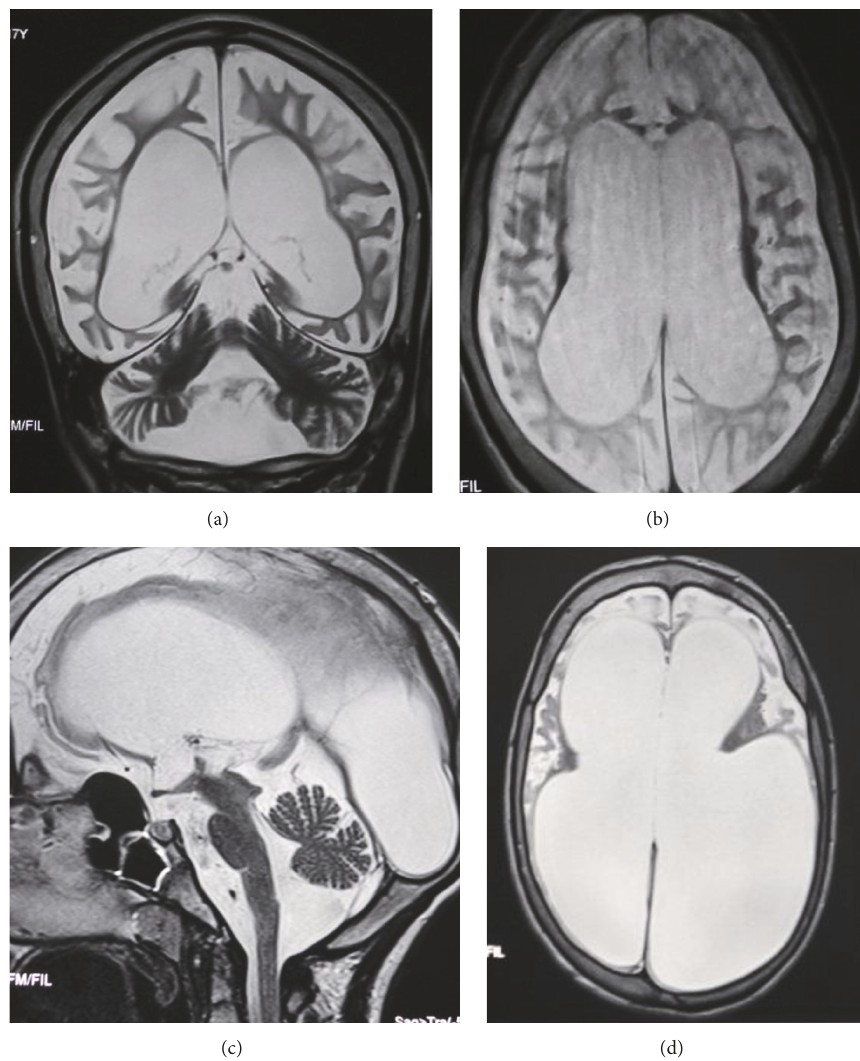
Figure 2: Brain MRI of the patients V.1 ((a) and (b)) and V.2 ((c) and (d)). (a) Coronal T2 weighted image showing enlargement of the cortical furrows and the ventricular cavities related to a diffuse cortical and subcortical atrophy. (b) Axial T2 weighted sequence showing the huge cortical and subcortical atrophy. (c) T2 weighted sequence shows dilatation in all ventricular cavities as a result to a diffuse and severe atrophy in the brainstem and the cerebellar and the sustentorial area. (d) T2 weighted sequence showing a major ventricular dilatation due to the severe cortical